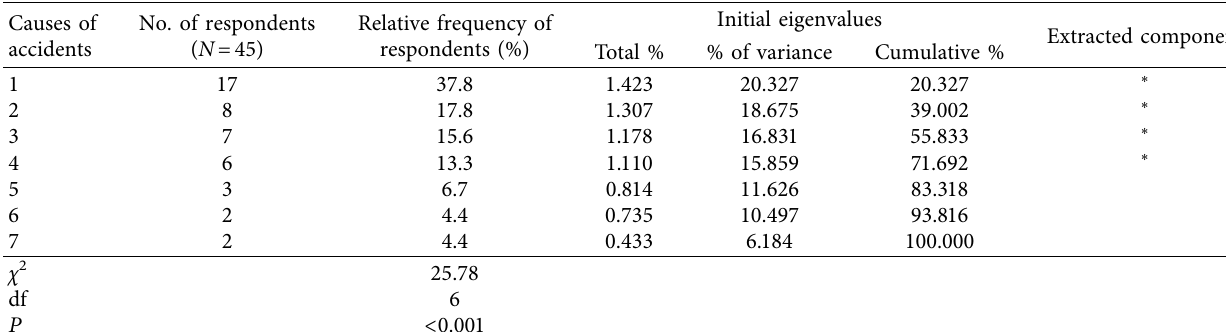
Table 1: Response frequencies and variance account on causes of accidents.